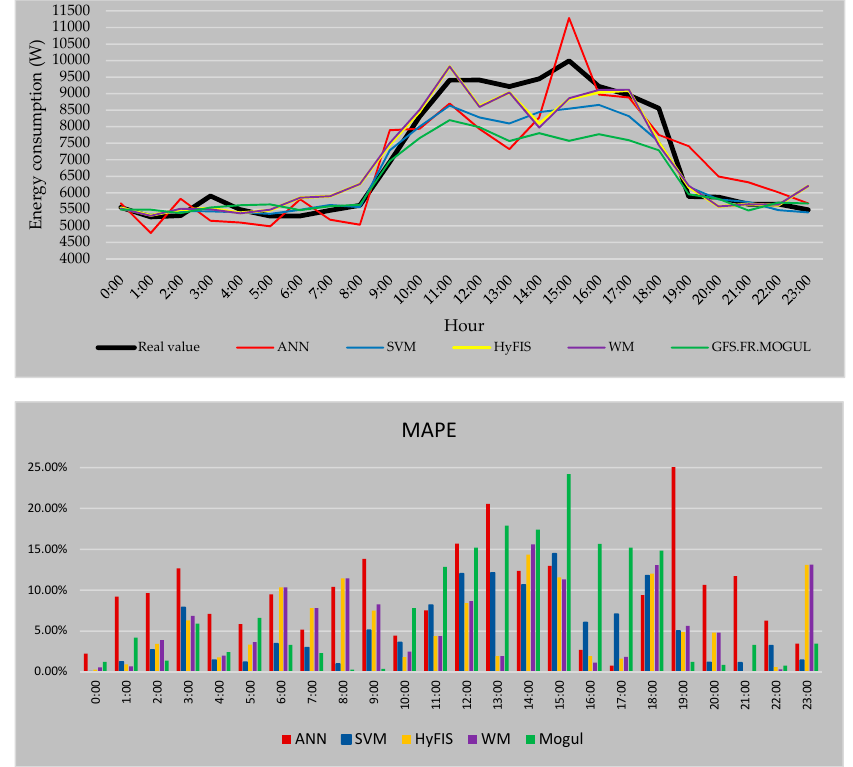
Figure 13. Forecasted values and error of the methods using the 2st data preparation strategy.